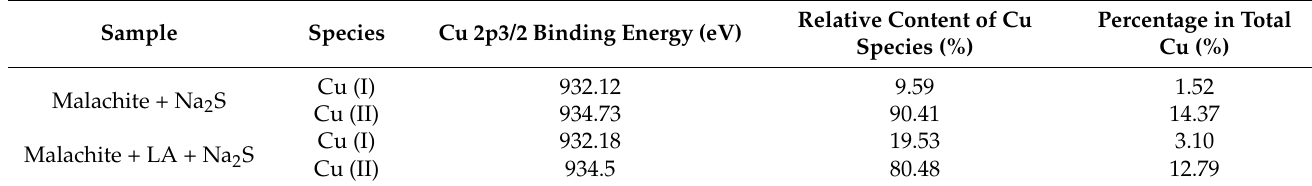
Table 3. Contents and percentages of different Cu species in total Cu on the malachite surface.